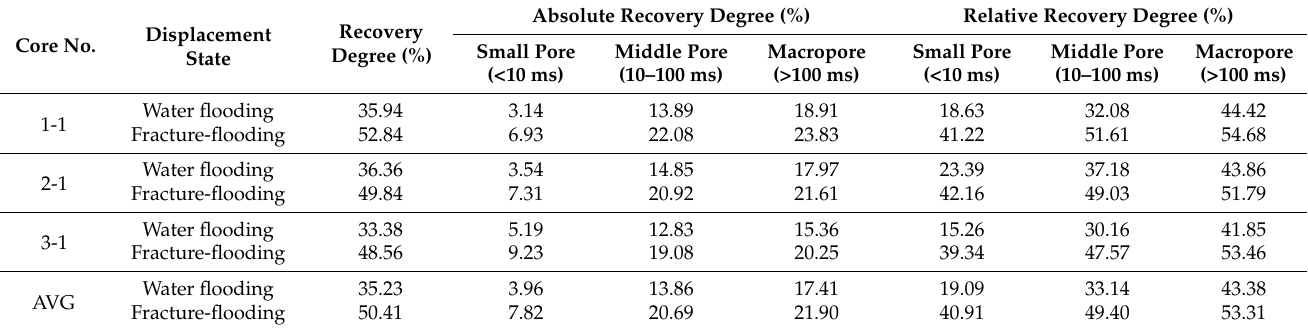
Table 2. Recovery degree table of different pore areas of T 2 spectrum under different displacement states.